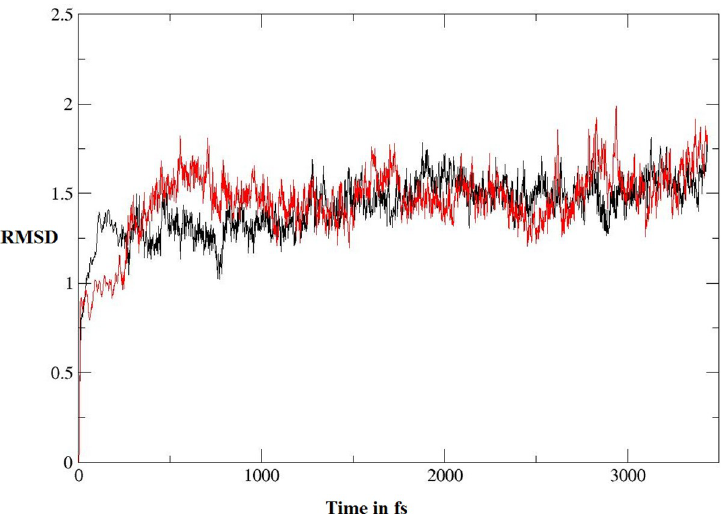
Fig 8. Intermolecular interactions of docked 7-methoxy-indolizine analogues 5a–5j at the active site of the enoyl- [acyl-carrier] protein-reductase enzyme.